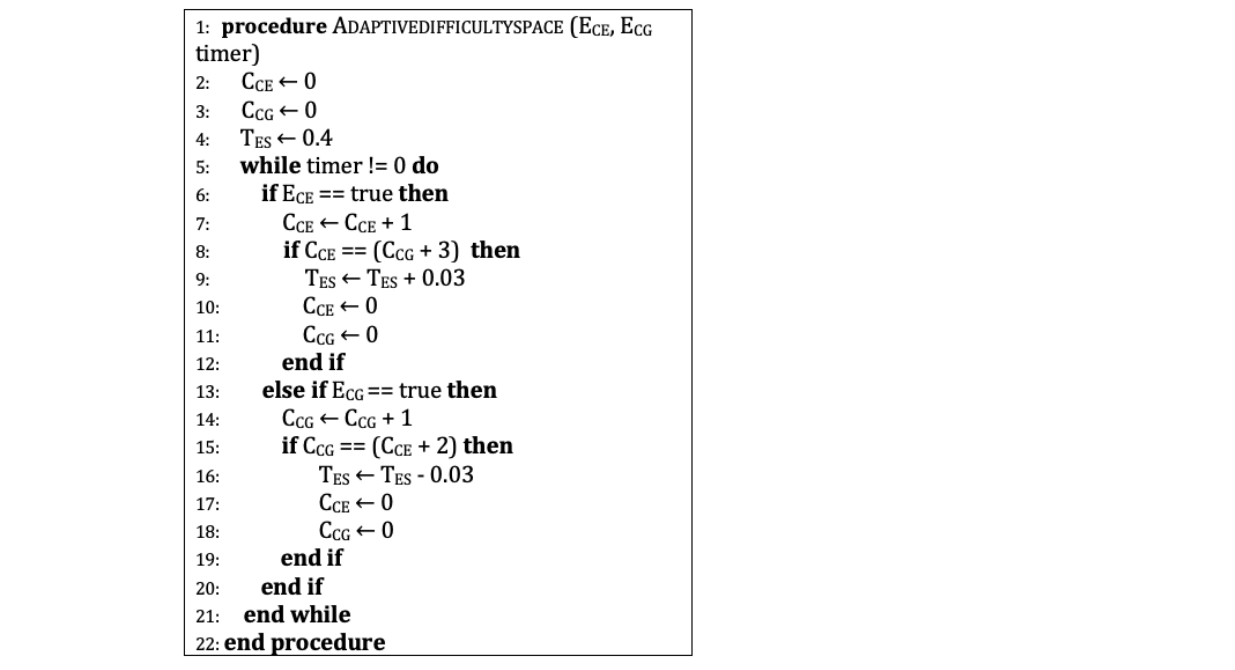
Figure 7. Adaptive difficulty